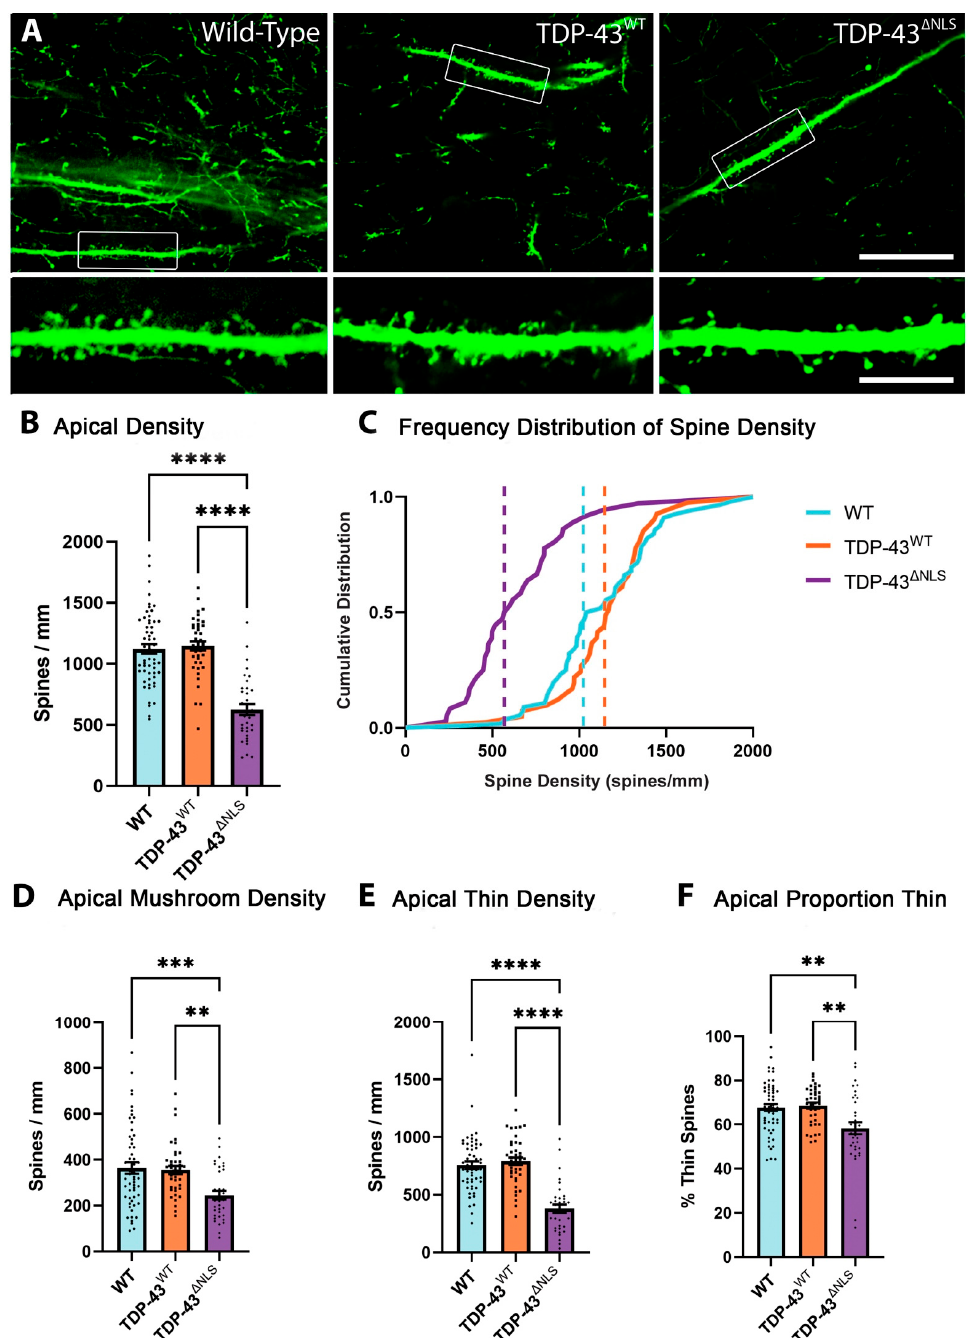
Figure 4. Apical trunk dendrites show reduced spine density in TDP-43 ∆ NLS layer V cortical motor neurons. ( A ). Rep- resentative images of WT, TDP-43 WT and TDP-43 ∆ NLS apical trunk dendrites. ( B ). The density of spines on apical trunk dendrites was reduced in TDP-43 ∆ NLS neurons compared to WT (H (2) = 51.0, p < 0.0001) and TDP-43 WT ( p < 0.0001). ( C ). The frequency distribution of apical trunk spine density, dotted lines represent the median. Almost all WT and TDP-43 WT dendrites have a higher density of spines than 50% of TDP-43 ∆ NLS dendrites. ( D ). There was a reduction in mushroom spine density on TDP-43 ∆ NLS apical trunk dendrites compared to WT (H (2) = 15.4, p = 0.0007) and TDP-43 WT ( p = 0.0042). ( E ). TDP-43 ∆ NLS apical trunk dendrites exhibit a reduced density of thin spines compared to WT (H (2) = 49.4, p < 0.0001) and TDP-43 WT ( p < 0.0001). ( F ). Apical trunk dendrites have a reduced proportion of thin spines in TDP-43 ∆ NLS neurons (H (2) = 11.6, p = 0.0019 to WT and p = 0.0015 to TDP-43 WT ). ** p < 0.01, *** p < 0.001, **** p < 0.0001, Kruskal–Wallis one-way ANOVA with Dunn’s multiple comparisons. Scale bar = 30 µ m, inset 7.5 µ